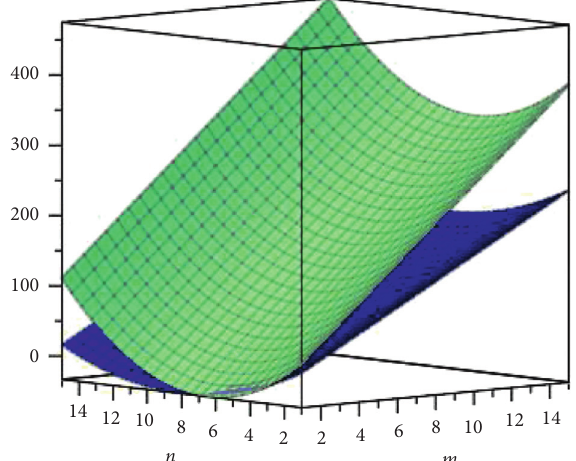
Figure 8: Graph for ( α � 2 ) 8 2 ( nm − n ) + 2 . 8 2 ( mn − m ) + 6 n